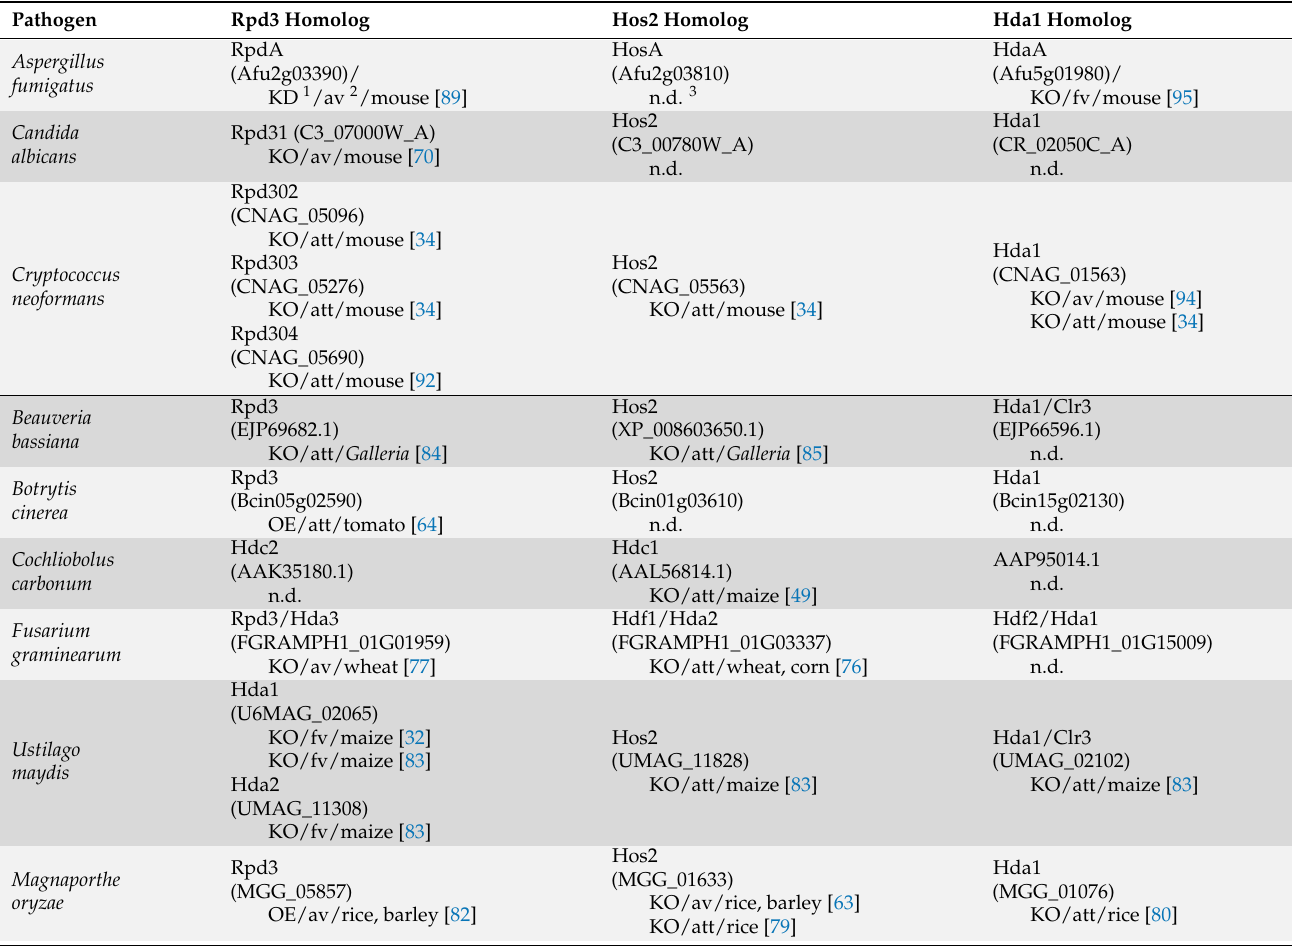
Table 1. Virulence phenotypes of fungal pathogen lysine deacetylase (KDAC) mutants. Names of KDACs and their FungiDB [99] or NCBI accession number, followed by the respective genetic modification, virulence phenotype, and host organism, are shown. Human- (top) and mainly plant-pathogenic (bottom) species are separated by a border